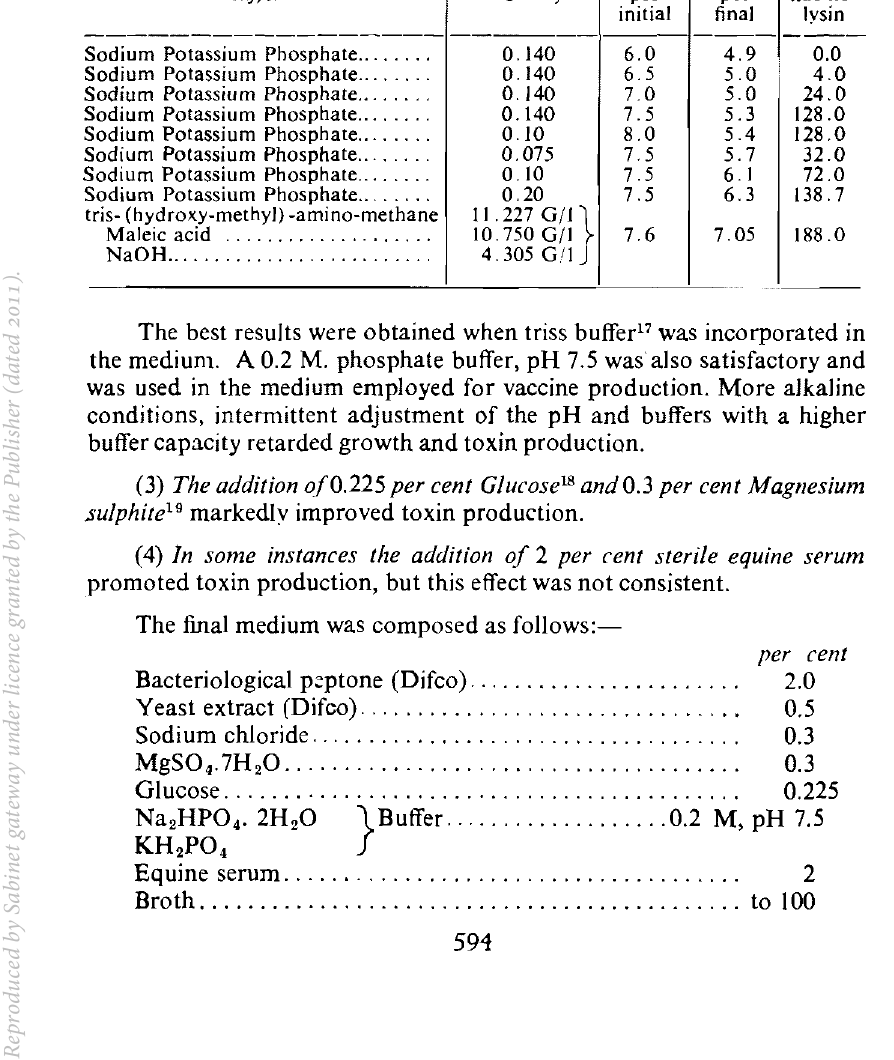
THE INFLUENCE OF BUffERS AND pH ON TOXIN PRODUCTIOlli AVERAGE